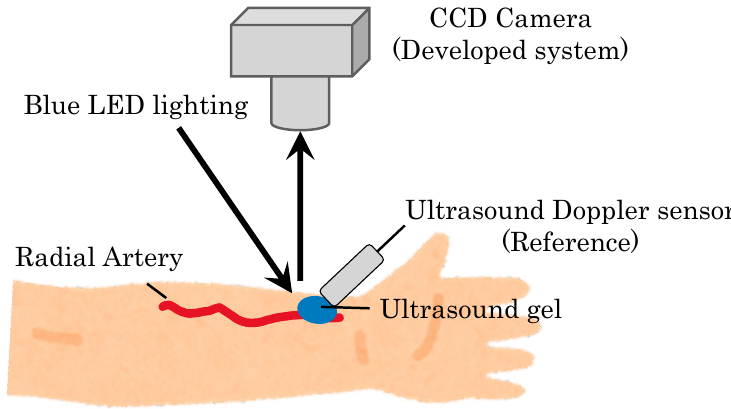
Figure 9. Setup for comparison between contact and non-contact